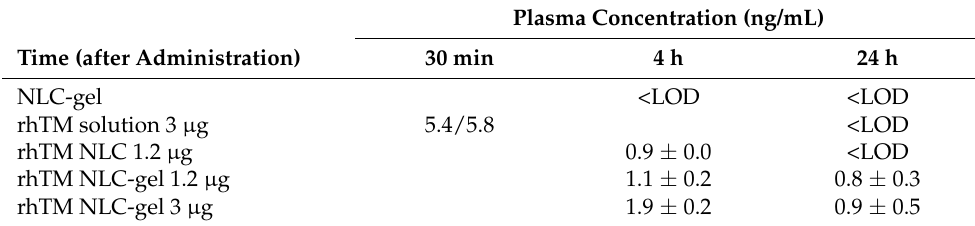
Table 1. Plasma rhTM levels post different